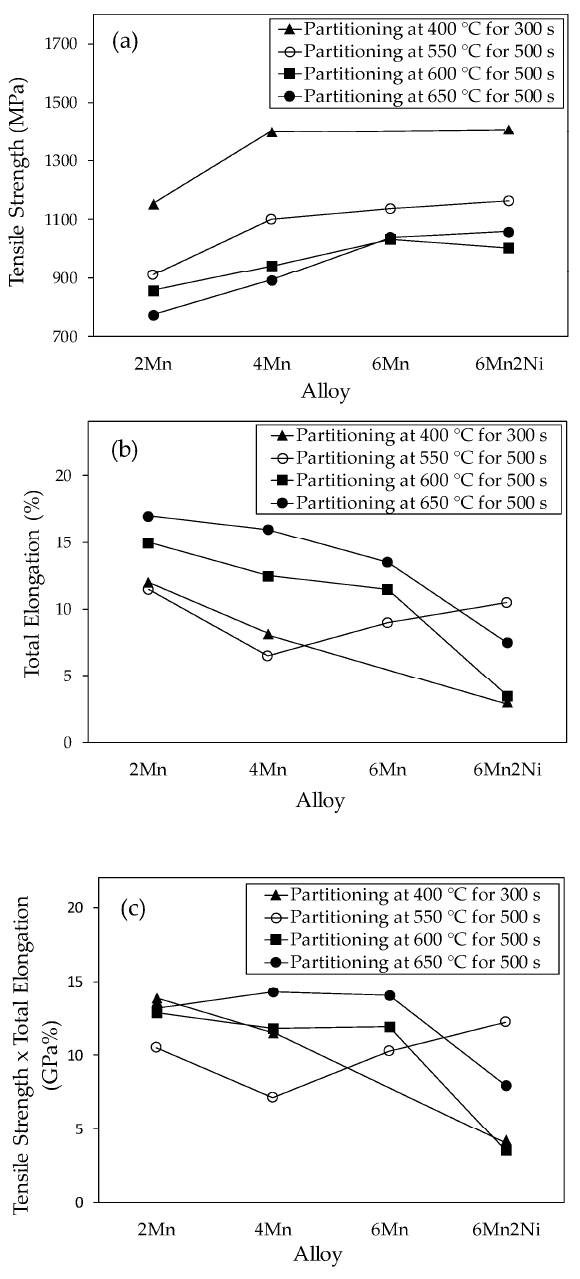
Figure 9. Tensile properties obtained in the Q&P processed steels, partition treated at 400 °C, 550 °C, 600 °C, and 650 °C representing: ( a ) tensile strength; ( b ) total elongation; ( c ) product of tensile strength and total elongation.